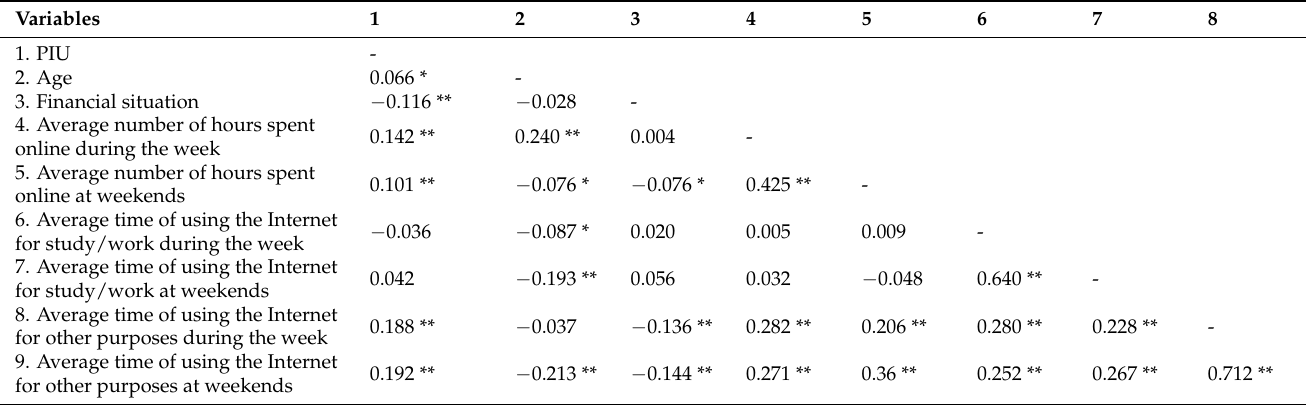
Table 5. Spearman’s correlations between the severity of PIU and selected